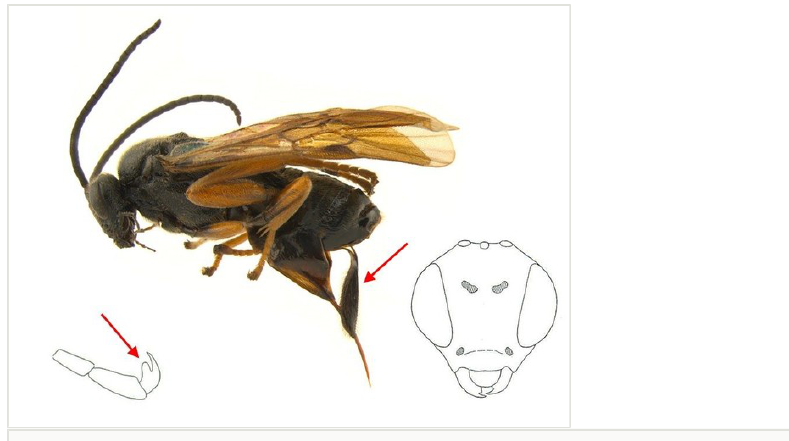
Figure 2. Microgaster deductor specimen from Churchill, Manitoba. Red arrows show a lobed tarsal claw and the ovipositor sheaths. Frontal view of head modified from Nixon (1968).